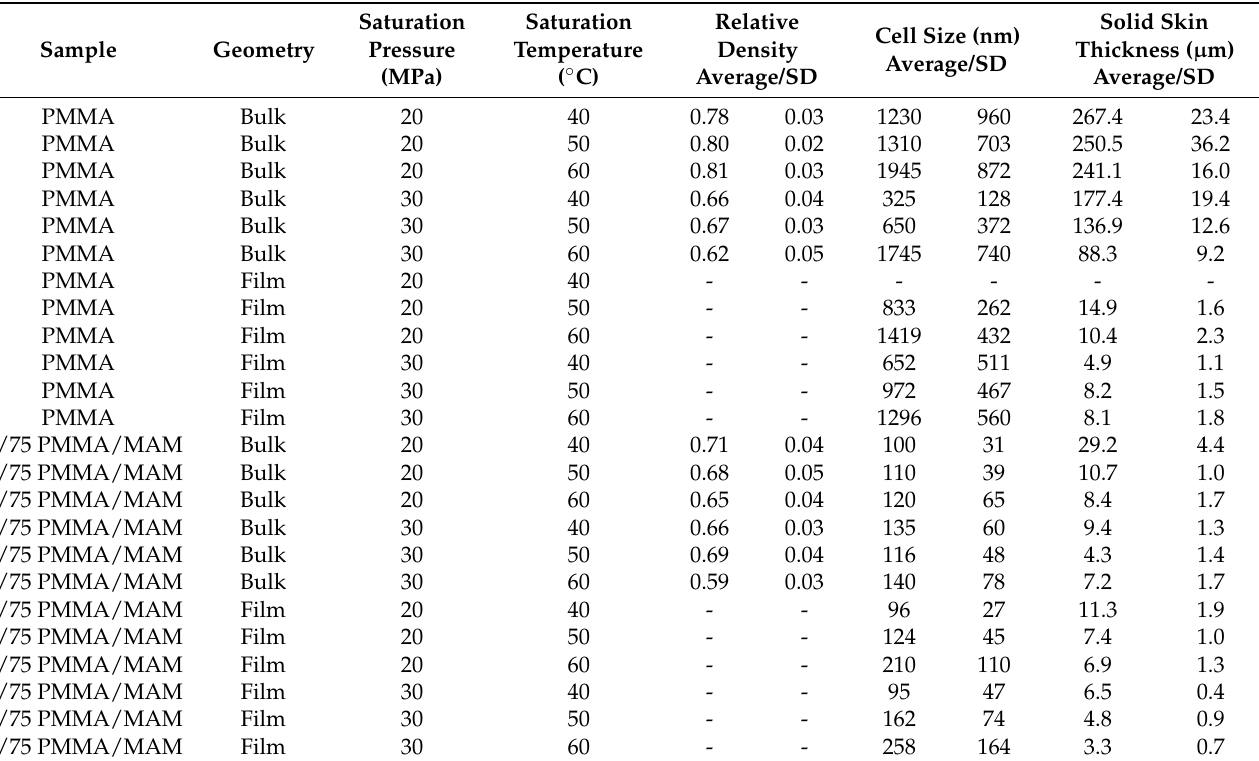
Table 1. Main characteristics of the neat PMMA and 25/75 PMMA foams obtained in a one-step foaming process. Histograms of the cell size distribution of each sample can be found in Figure S8, see Supplementary Materials.